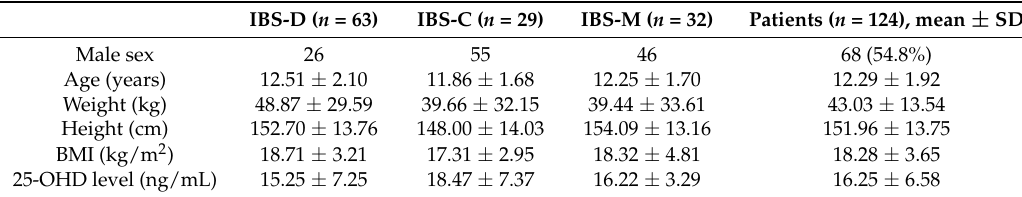
Table 1. Baseline characteristics of all patients.